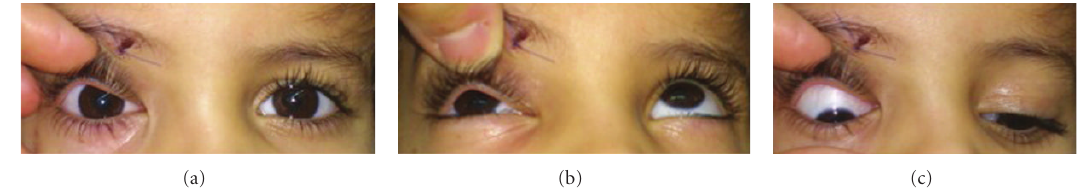
Figure 1: Patient gaze assessment photographs demonstrating the sutured site of foreign body penetration, slight downward right eye deviation on primary gaze (a), limitation of upward gaze (b), and exaggerated downward gaze (c).